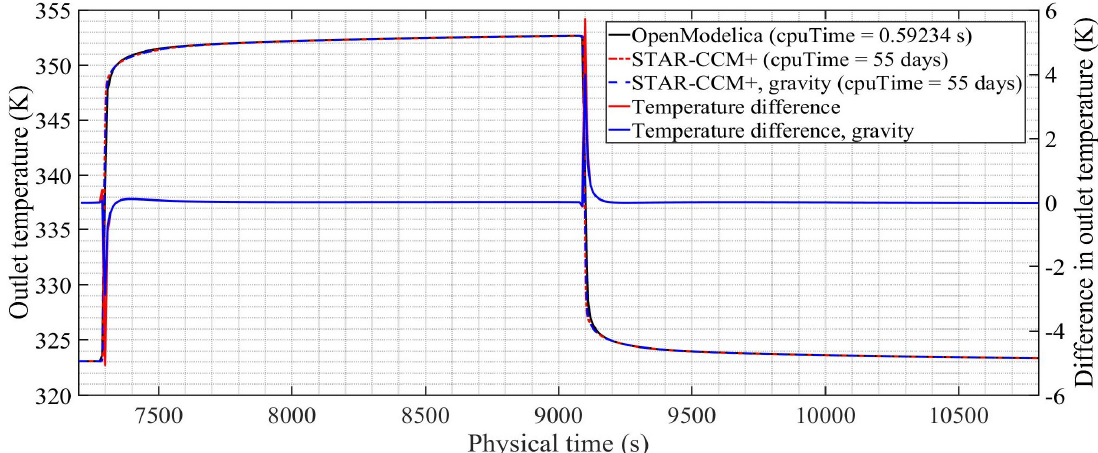
Figure 24. Detail of the difference in temperature on comparison with a model from Fluent.